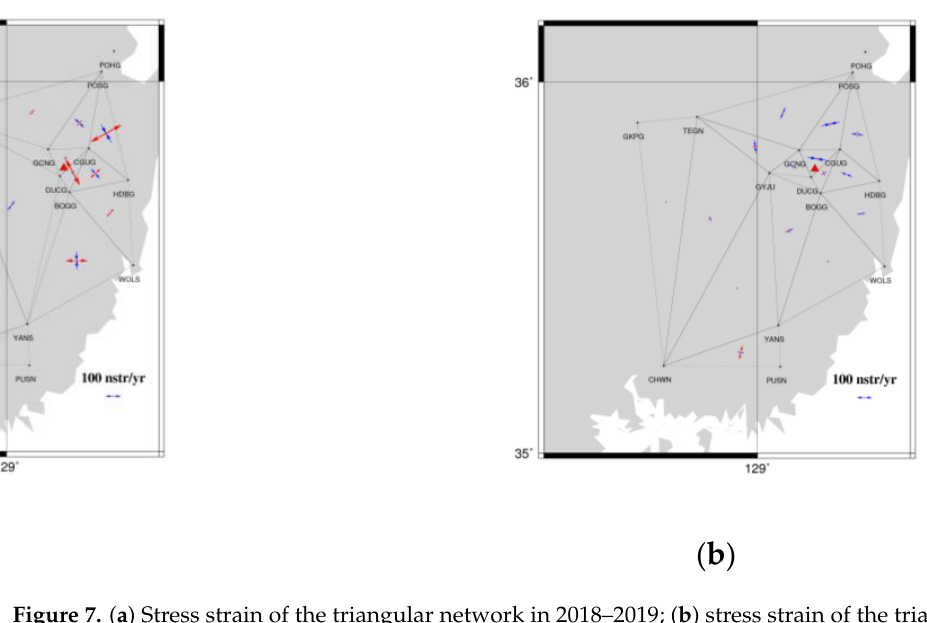
coordinates. Neglecting the curvature of the earth, the triangular network was assumed to be a two-dimensional plane. No triangle’s circumcircle contains any other points except the three vertices of the triangle in this method. The stress strain and area strain of the triangular network was calculated using the baseline distance change rate between the stations. Figure 7 show the stress strain rate for each triangle network calculated for each period. Table 5 shows the calculated principal strain, maximum shear strain, and area strain of the triangle network. From 2018 to 2019, there is a total of four triangles with a maximum shear strain of 200 nstr or more in absolute sense. The triangle with a maximum shear strain is CGUG-HDBG-POSG with the magnitude of 356.5 nstr/year. In addition, the triangular network of BOGG-CGUG-DUCG shows the largest area strain with a scale of 167.2 nstr/year. On the contrary, there was no triangle with a maximum shear strain of 200 nstr or more in the result of 2020 to 2021, but the CGUG-DUCG-GCNG triangle was the largest at 140.2 nstr/year during this period. This triangular network (CGUG-DUCG- GCNG) includes the area where the Gyeongju earthquake, the largest earthquake since the instrumental earthquake, occurred on the Korean Peninsula. According to previous studies, after the Tohoku Earthquake occurred in 2011, the principal stress acting on the Korean Peninsula contracted in the north–south direction and expanded in the east–west direction [21]. Since then, the scale has decreased. Most of the results of this study showed that the stress strain becomes smaller during the period. During the period between 2018 and 2019, many expanding triangles were observed in the network, but the scale has decreased significantly afterwards. Thus, it can be concluded that the stress of the crust around the Yangsan Fault Zone decreases over time based on the results from 2018 to 2021, which might be evidence of a stable state (here, nano-strain is 10 − 9 mm/mm and symbolized as nstr).